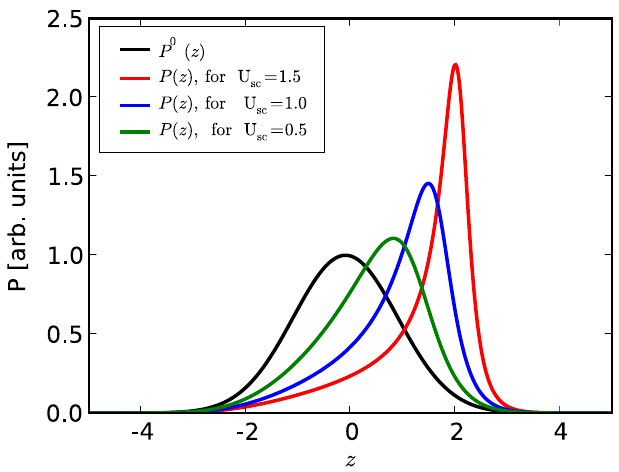
FIG. 1. (Color) P (cid:2) z (cid:3) from Eq. (17) for an upper sideband and for (cid:4) 0 . with U different U sc coh